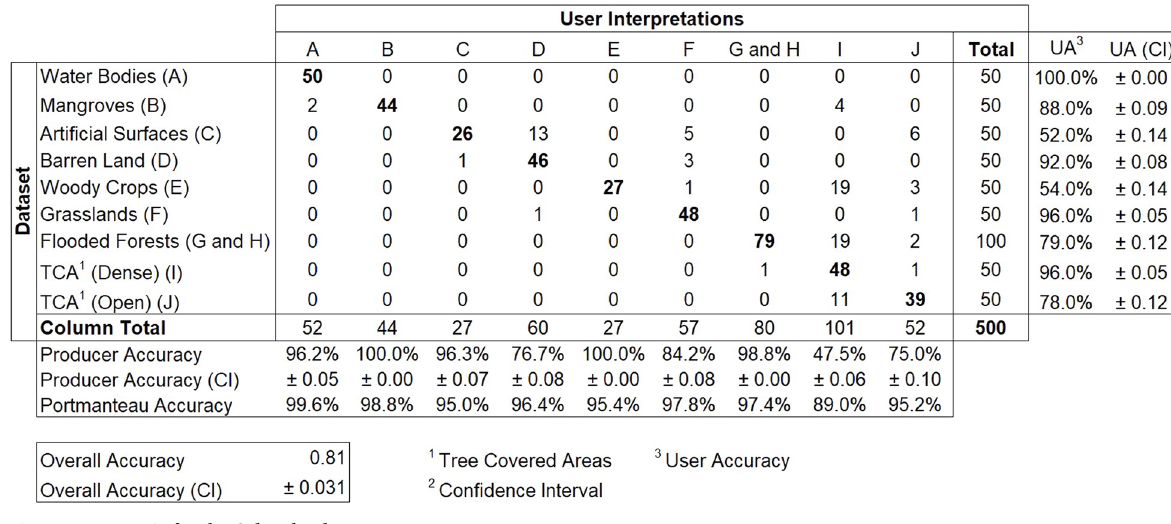
Fig 8. Error matrix for the Gabon land cover